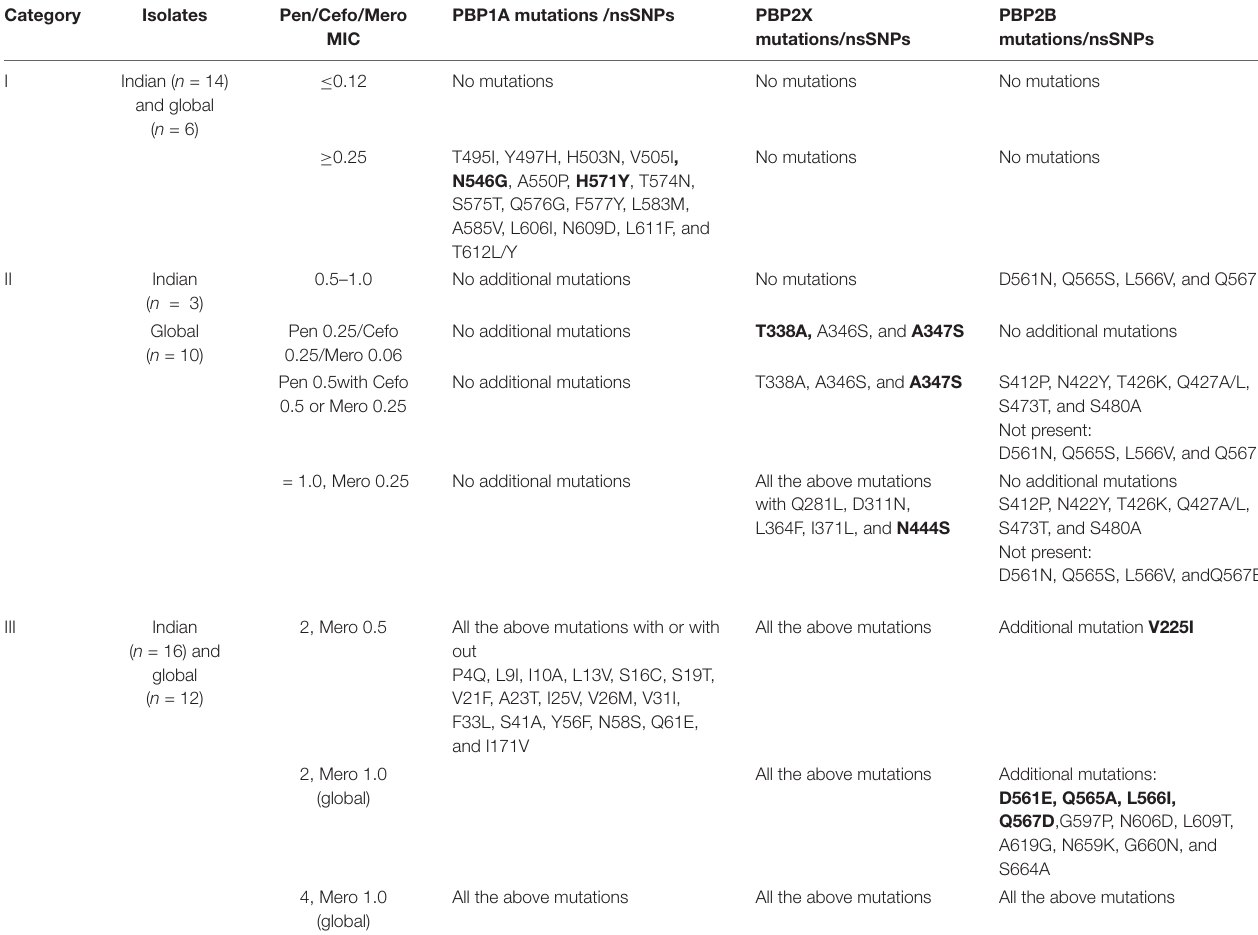
TABLE 1 | The PBP mutations of the representative Indian and global isolates based on the MICs of cefotaxime, meropenem, and penicillin.